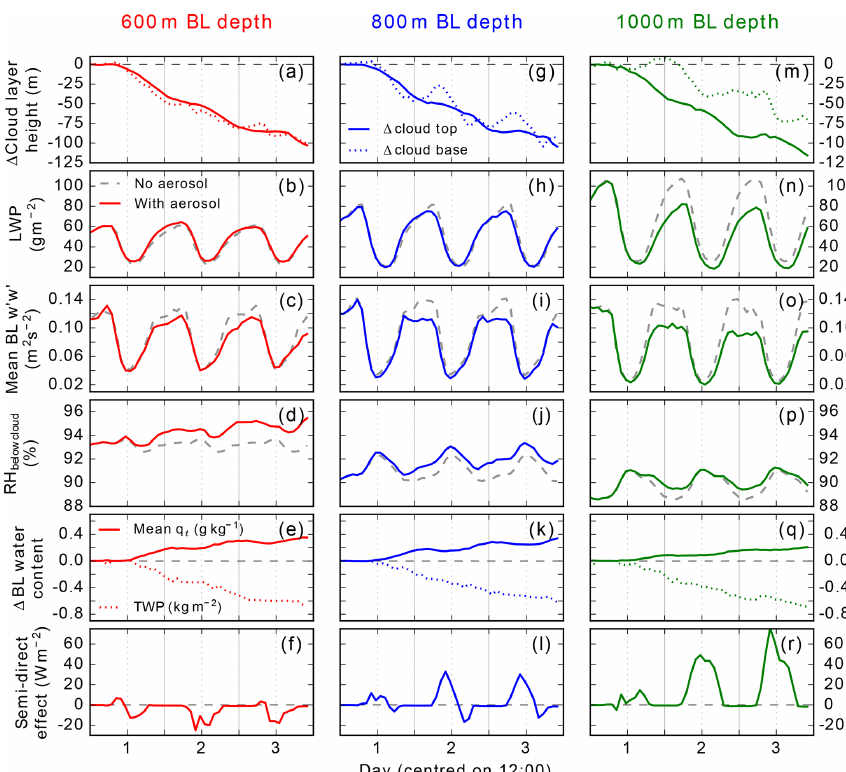
Figure 10. 3d time series showing the initial response of the cloud to a 250m thick layer of aerosol directly above the inversion with an aerosol optical depth of 0.2 from the (a) – (f) control setup with a boundary layer depth of 600m, (g) – (l) 800m setup, and (m) – (r) 1000m setup. From the top to bottom row, panels show the altitude of the cloud base and top, the liquid water path (LWP), the mean boundary layer (BL) vertical velocity variance ( w (cid:48) w (cid:48) ), the mean relative humidity (RH) between the ocean surface and the cloud base, changes to the BL water content as the mean total water content q t and the total water path (TWP), and the semi-direct